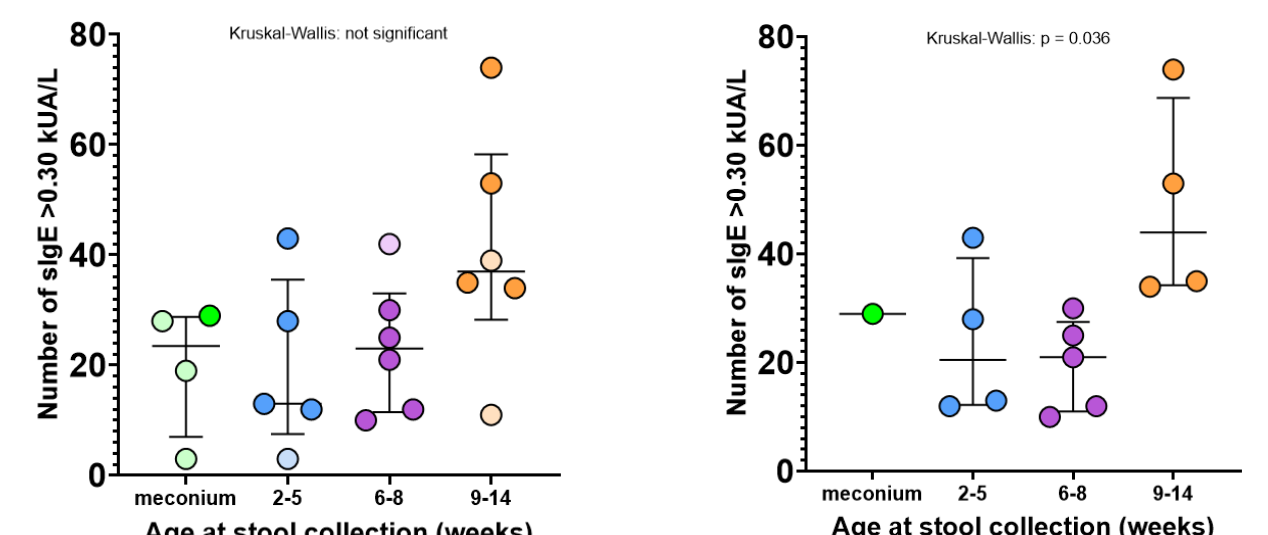
Figure 1. Number of multiplexed allergens displaying fecal sIgE binding as a function of age at stool collection. ( a ) All fecal samples; ( b ) fecal samples from patients diagnosed with CMA, asthma, or AD at the age of 1. The colors denote the age at which the samples were taken (green: meconial; blue: 2–5 weeks; purple: 6–8 weeks; orange: 9–14 weeks), with the light shades denoting the control subjects and the dark shades denoting the patients who developed IgE-mediated diseases by the age of 1. AD, atopic dermatitis; CMA, cow’s milk allergy.